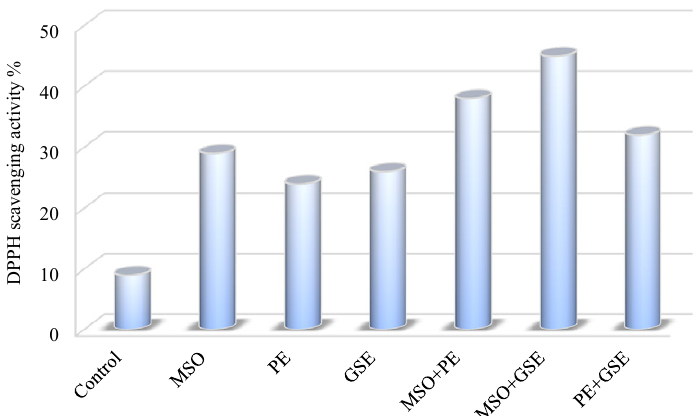
Fig. 5. DPPH scavenging activity of nanochitosan film incorporated with M. spicata essential oil (MSO), pomegranate peel extract (PE) and grape seed extract (GSE)